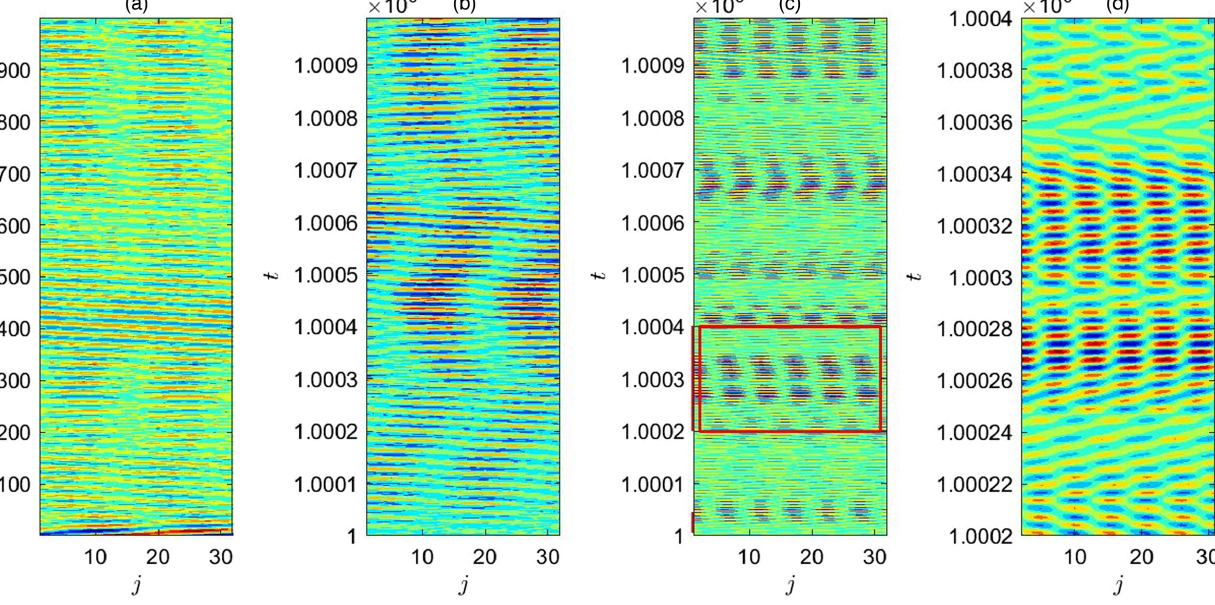
FIG. 10. Color map of the displacement q j ð t Þ for ϵ ¼ 0 . 54 : (a) initial traveling wave, 0 < t < 1000 , (b) standing wave structure in thermal equilibrium, 10 6 < t < 10 6 þ 1000 , (c) ˜ q j ð t Þ , displacement after removing wave numbers k ¼ 1 ; … ; 3 ; 5 ; … ; N , (d) closer look at the boxed region in